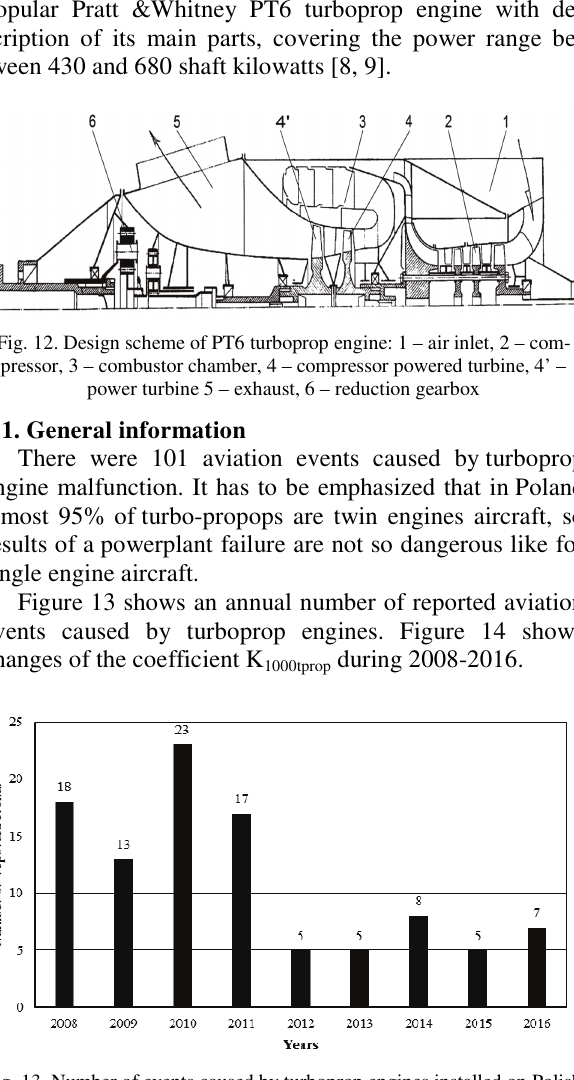
Fig. 13. Number of events caused by turboprop engines installed on Polish registered aircraft between 2008-2016